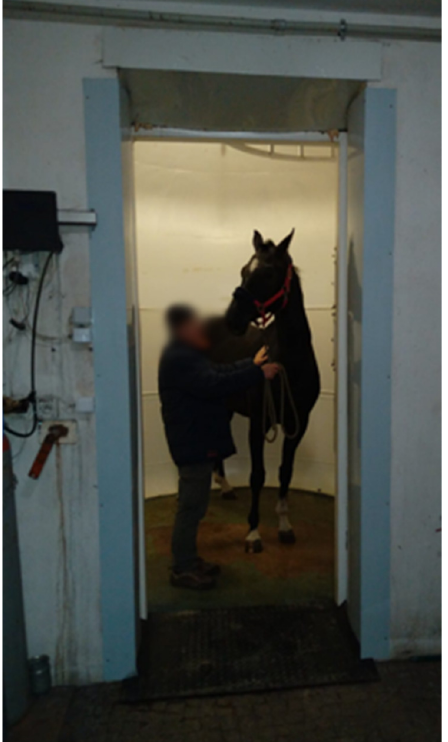
Figure 13. Horse placed in a hyperbaric chamber prior to therapy.